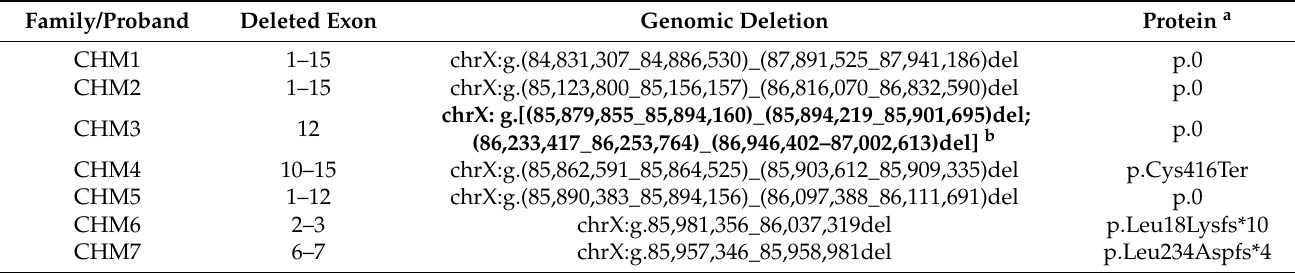
Table 1. CHM deletions identified in Italian patients with